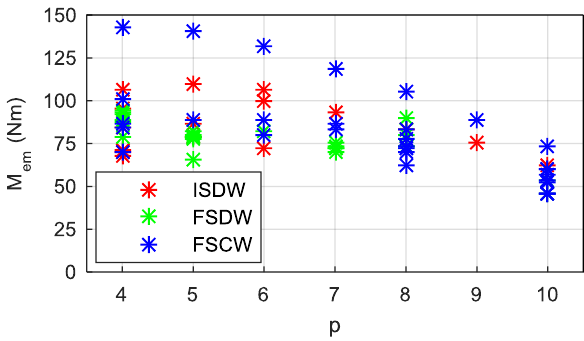
Figure 7. Mean electromagnetic torque ( M em ) versus pole pair number ( p ) and winding type.